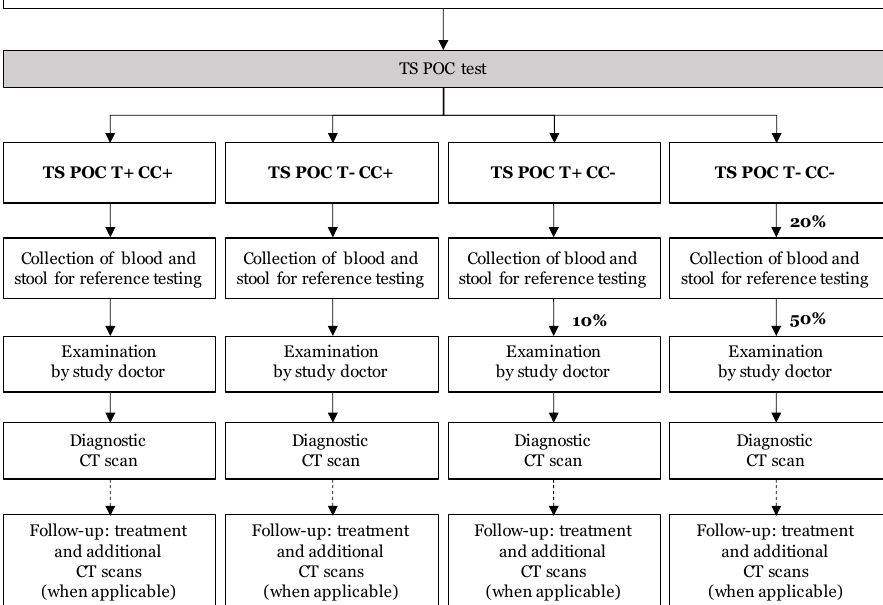
Figure 1. Flow of the community-based diagnostic accuracy study in Zambia within the SOLID project. In this two-stage design, all participants were tested using the TS POC test (=index test; stage 1), after which all positive and a subset of negative participants (indicated as percentages) were selected for reference tests, clinical examination, and a brain CT scan (stage